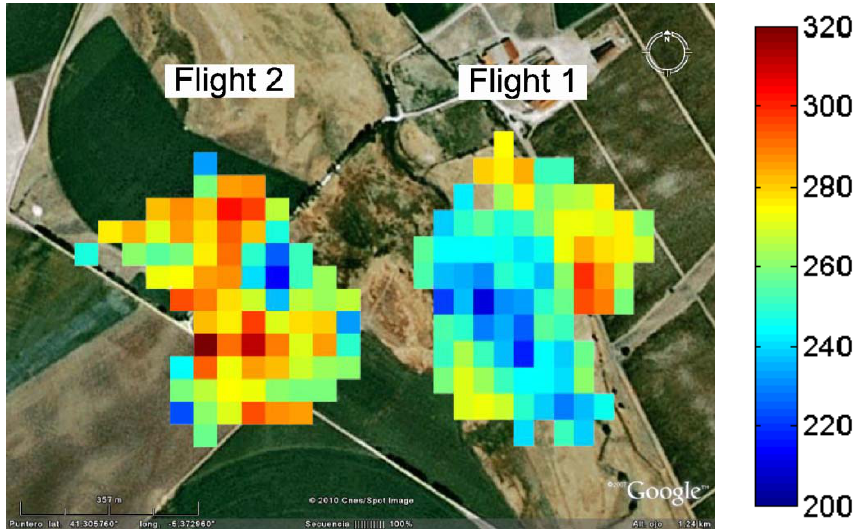
Figure 12. UPC Airborne Radiometer at L-band (ARIEL) retrieved TB [K] obtained at heights 140 ± 30 m (spatial resolution ~50 m), re-sampled to a 60 × 60 m grid and geo-referenced on Google Earth (from